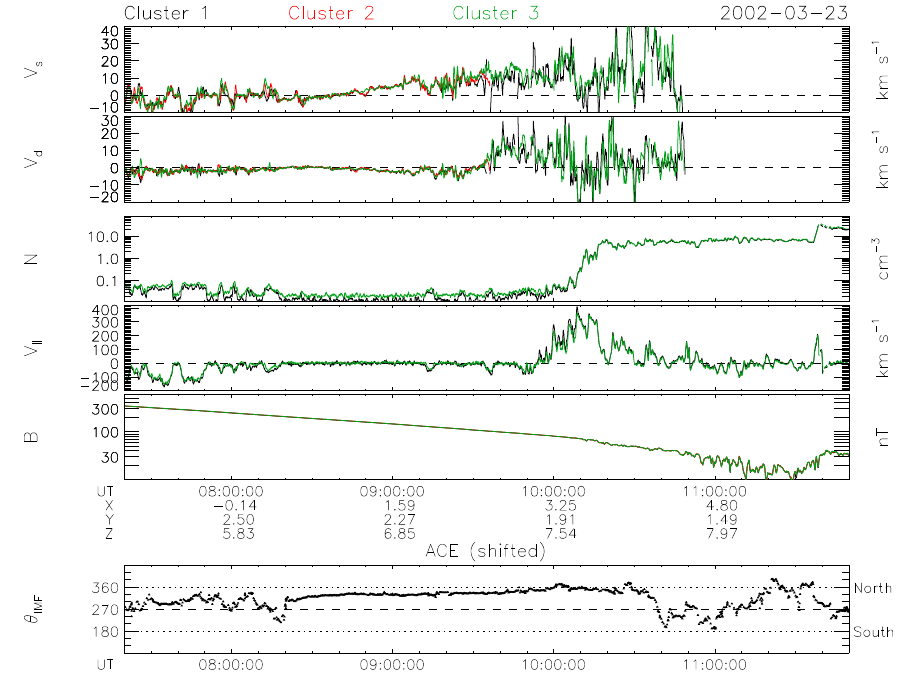
Fig. 5. Data for an outbound pass on 23 March 2002 over the northern polar cap towards the magnetopause, which is crossed near 11:40 UT. The average convection is mostly sunward, consistent with the mostly northward IMF. Note the downward directed high-speed plasma jets observed when entering the cusp near 10:00 UT. There are no useful EDI data after 10:50 UT because of the low and fluctuating magnetic field. EDI data on C2 stop even earlier because of operational restrictions.